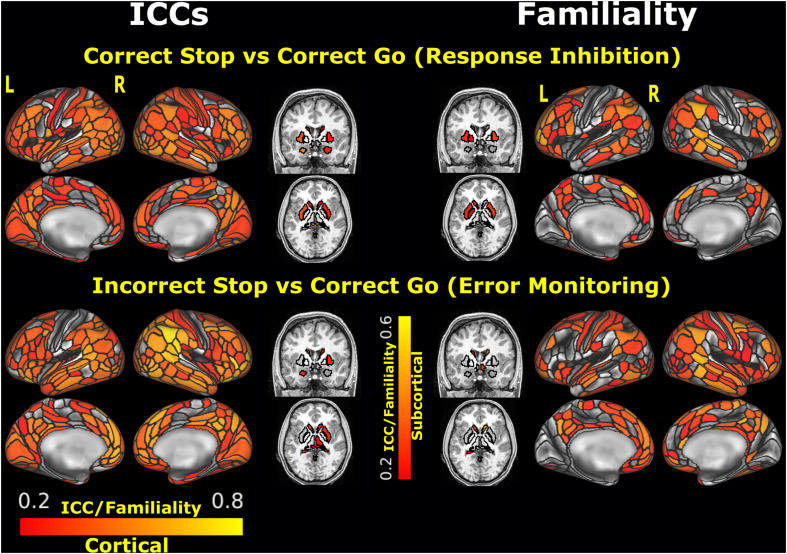
ICC estimates and MZ twin correlations for the unthresholded parcels analysis. Black outlines depict the boundaries of the MMP1.0 cortical parcelation and the Freesurfer segmentation. Parcels/segments with ICCs < 0.2 are not plotted. L: left, R: right. [ICCs of the unthresholded parcels can be found in the BALSA repository for neuroimaging data: https://balsa.wustl.edu/study/show/wN9n4].